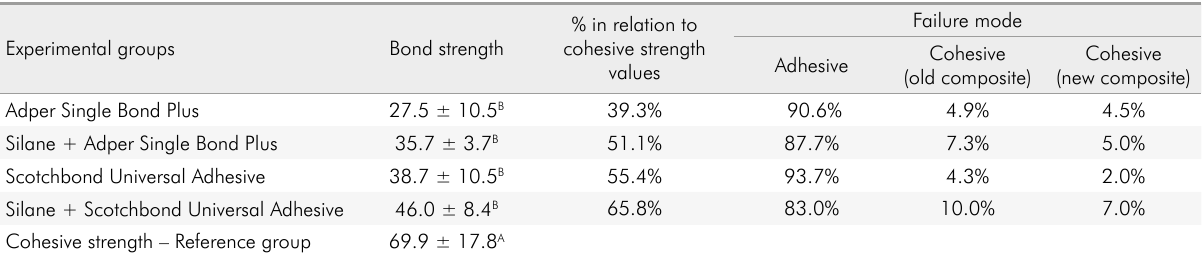
Table 2. The microtensile bond strength means (MPa), standard deviations, and distribution of the failure mode for all experimental groups Experimental groups